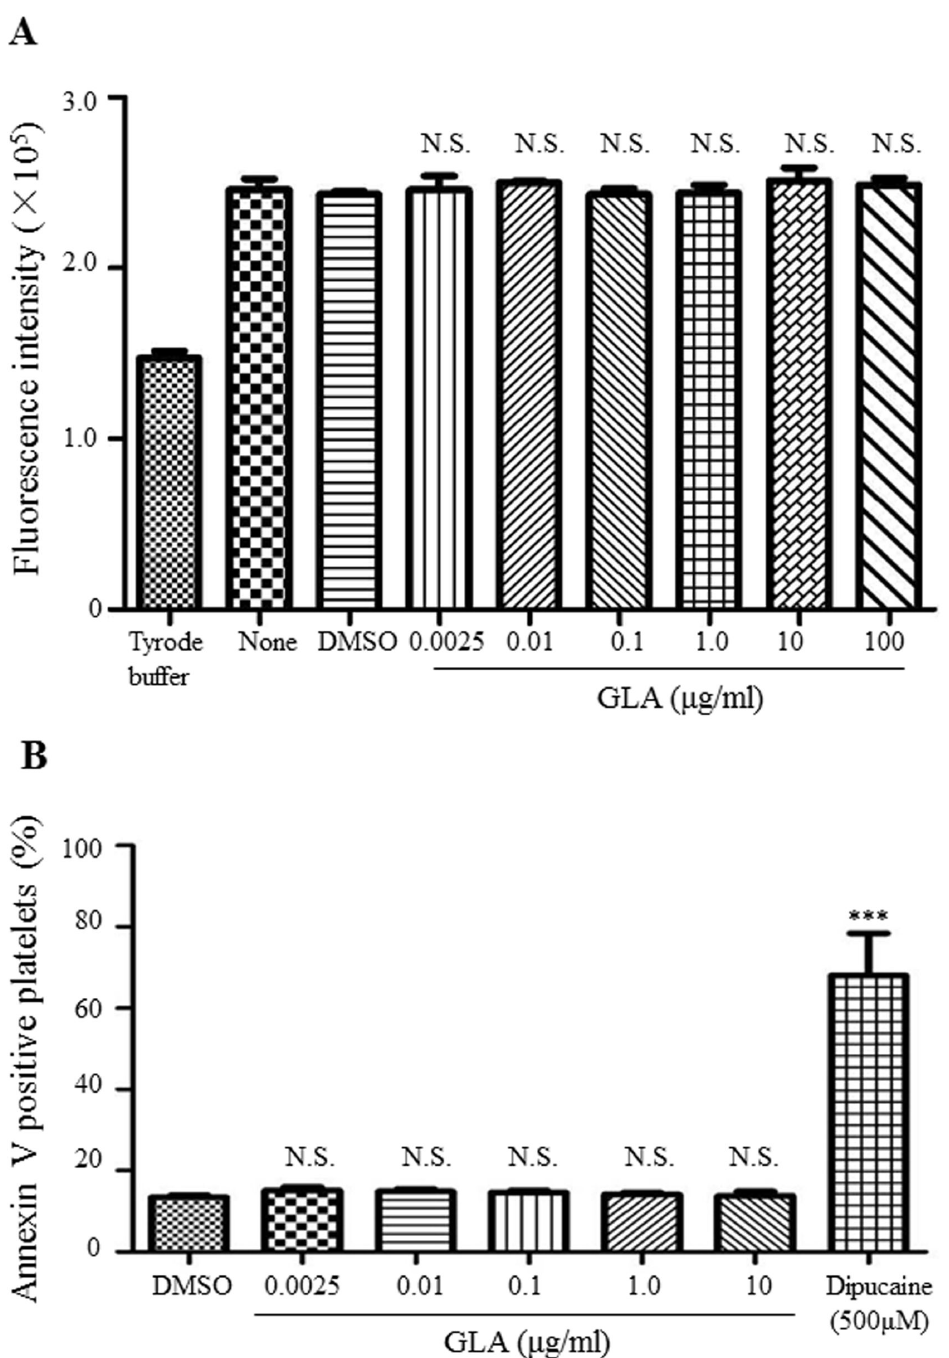
Figure 4. Evaluation of the potential toxic and apoptotic effect of GLA on platelets. (A) In platelet viability assay for the toxic effect of GLA, gel-filtered platelets (2.5×10 8 /ml) were preincubated with GLA (0.0025-100μg/ml) or vehicle and then incubated with Alamar Blue reagent for 4 hours at 37°C. The fluorescence was acquired with the excitation and emission wavelengths of 570 nm and 585 nm, respectively, and plotted in the bar charts (mean ± standard error, n=3). (B) In PS externalization assay, gel-filtered platelets (2×10 7 /ml) were preincubated with GLA (0.0025-10μg/ml) or vehicle or dibucaine (500μmol/Lol/L) at 37°C for 15 min, and then mixed with Annexin V binding buffer and Annexin V-APC. Samples were analyzed by flow cytometry and the percentage of annexin V positive platelets was calculated (mean ± standard error, n=3). ***P<0.001. N.S., not significant compared to vehicle control. The statistical significance was determined by one-way ANOVA analysis of variance with the Bonferroni post test. doi: 10.1371/journal.pone.0085120.g004 PLOS ONE |